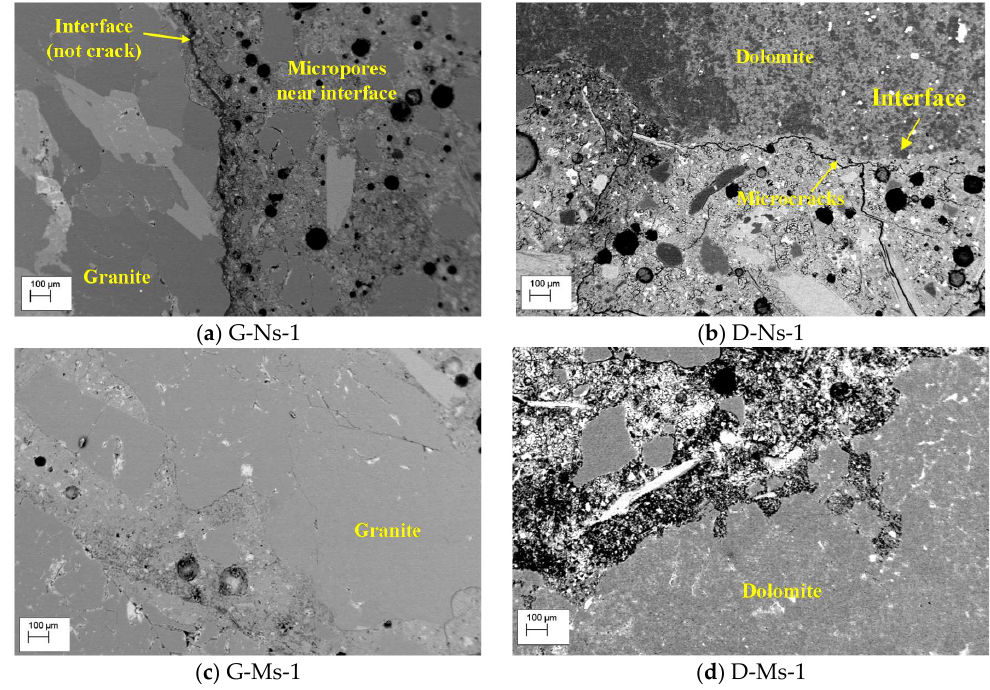
Figure 10. Backscatter SEM images showing microstructure (micro-pores and micro-cracks).